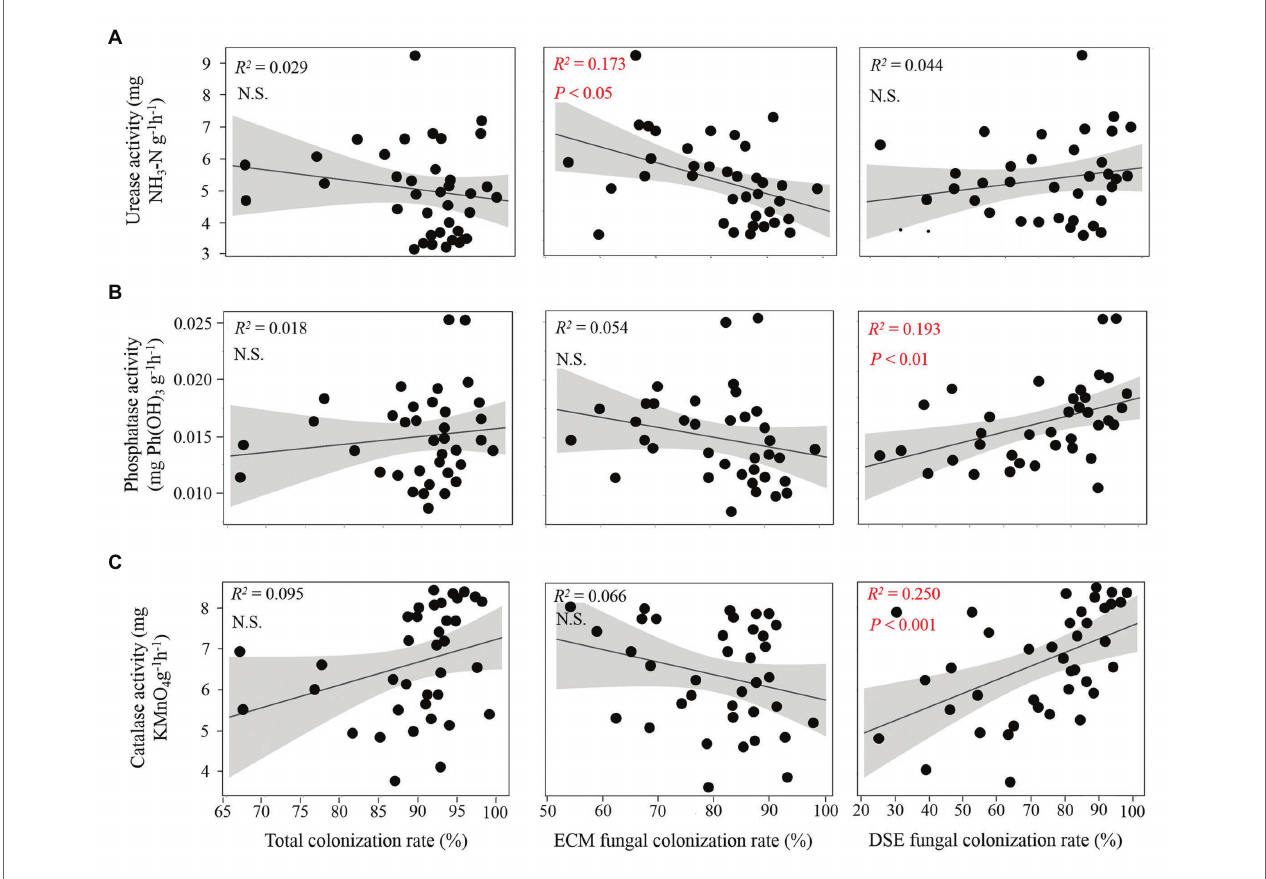
FIGURE 3 | Relationship between soil enzymatic activities and root fungal colonization rates. (A) The relationships between urease activity and fungal colonization rate of overall fungi, ectomycorrhizal (ECM) fungi and dark septate endophyte (DSE) fungi; (B,C) the relationships between fungal colonization rates and the soil enzymatic activities of phosphatase and catalase. The red color indicates a significant